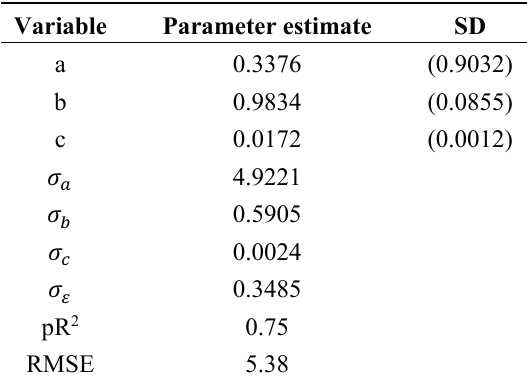
Table 2. Estimated parameters, standard deviation (SD), pseudo coefficient of determination (pR 2 , correlation coefficient between observed and predicted values) and root mean square error (RMSE) for applied height-diameter model.